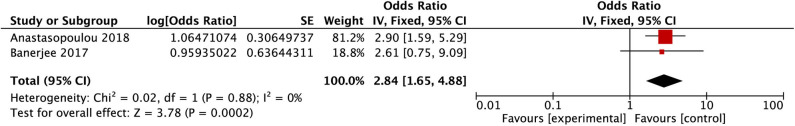
Forest plot for the incidence of T-cell leukemia. There is no obvious heterogeneity between the 2 records.